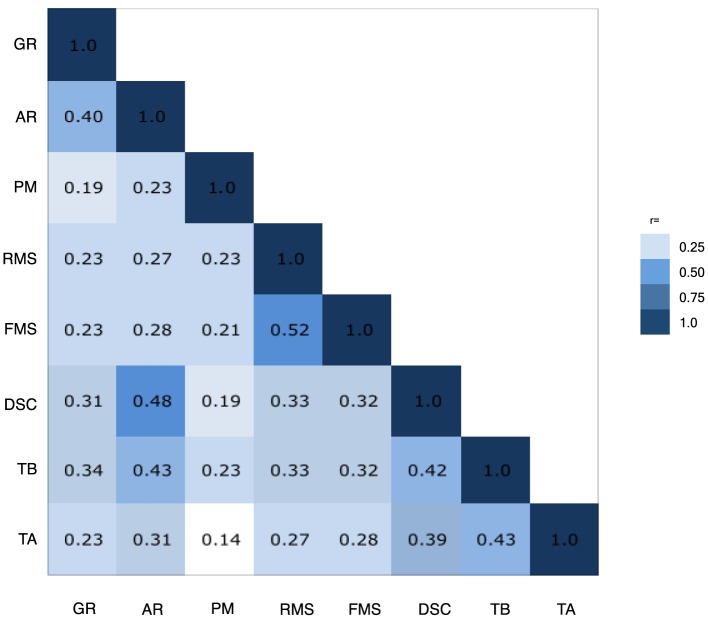
Inter-assessment correlations. Heat map showing that each NCPT subtest was significantly correlated with performance on more than one other subtest. The heat map suggests three groupings that share higher correlations, as follows: (1) Arithmetic Reasoning (AR), Grammatical Reasoning (GR), and Digit Symbol Coding (DSC); (2) Forward (FMS) and Reverse Memory Span (RMS); and (3) Trail Making A (TA) and Trail Making B (TB). Progressive Matrices (PM) does not appear to correlate strongly with any other subtest.